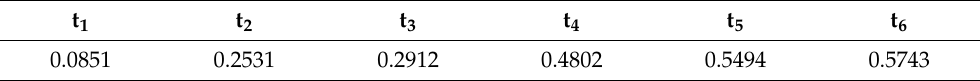
Table 1. Set of prescribed, randomly distributed t i values used for the MI algorithm.